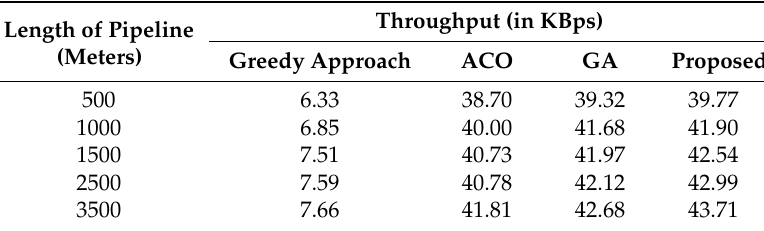
Table 5. Comparison of Throughput (Range 25 m).